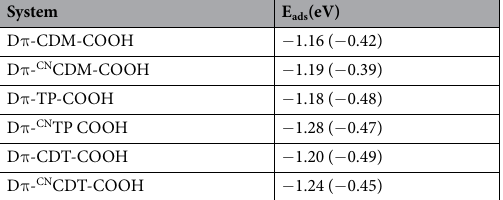
System E ads (eV) D π -CDM-COOH − 1.16 ( − 0.42)